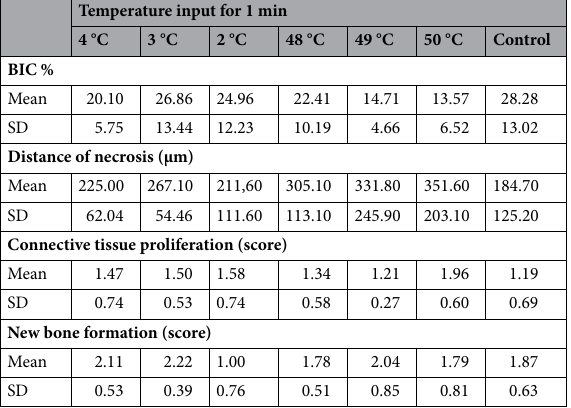
Table 2. This table showed the descriptive data (mean and standard deviation) of the BIC ratio, depth of necrosis, connective tissue proliferation and new bone formation around the implant bodies.